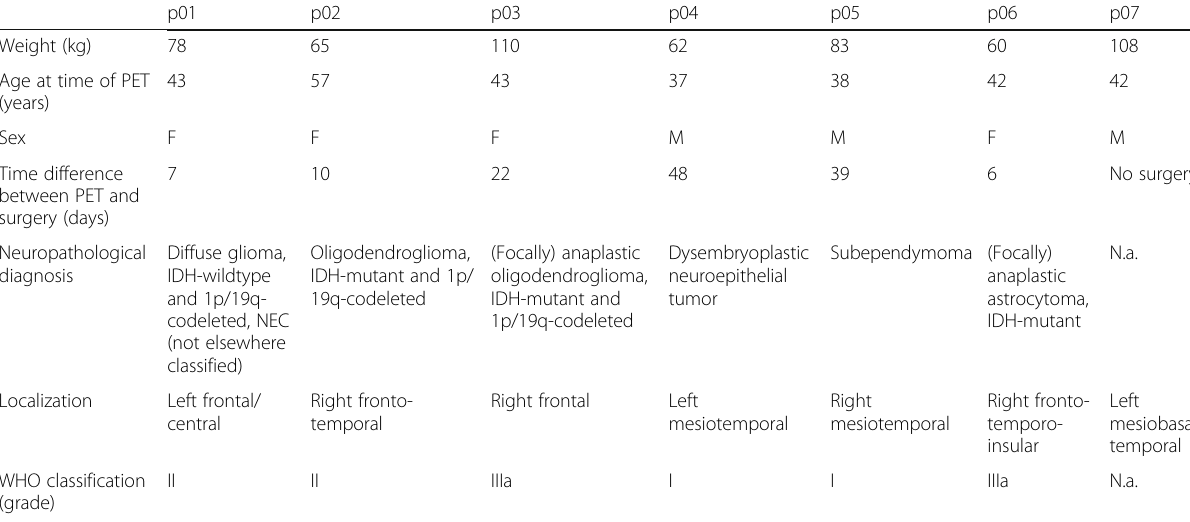
Table 1 Demographic data of enrolled brain tumor patients